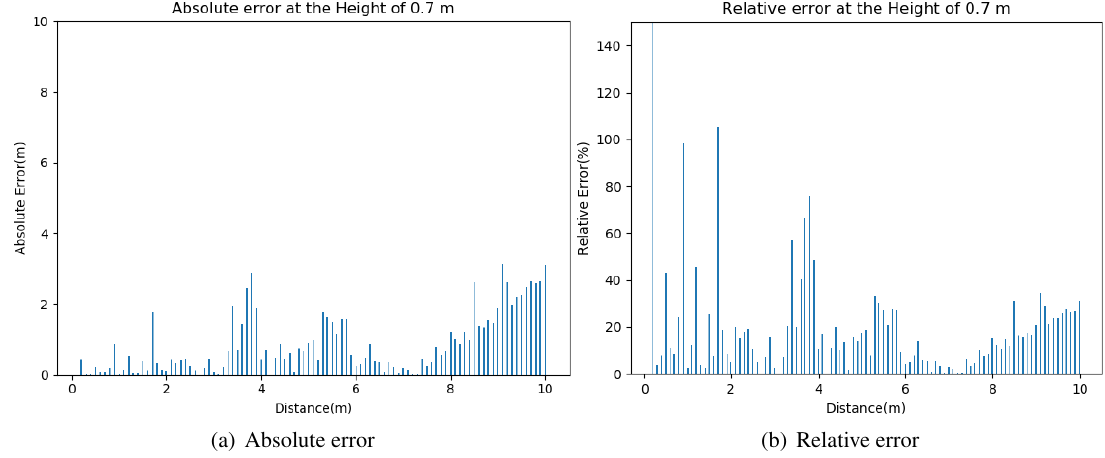
Fig. 5 Errors before and after the RSOA. RSOA, reference signal optimisation